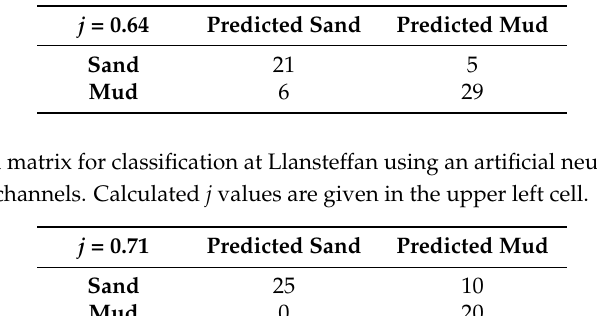
and NIR data channels. Calculated j values for the classification are also given in the upper left cell.